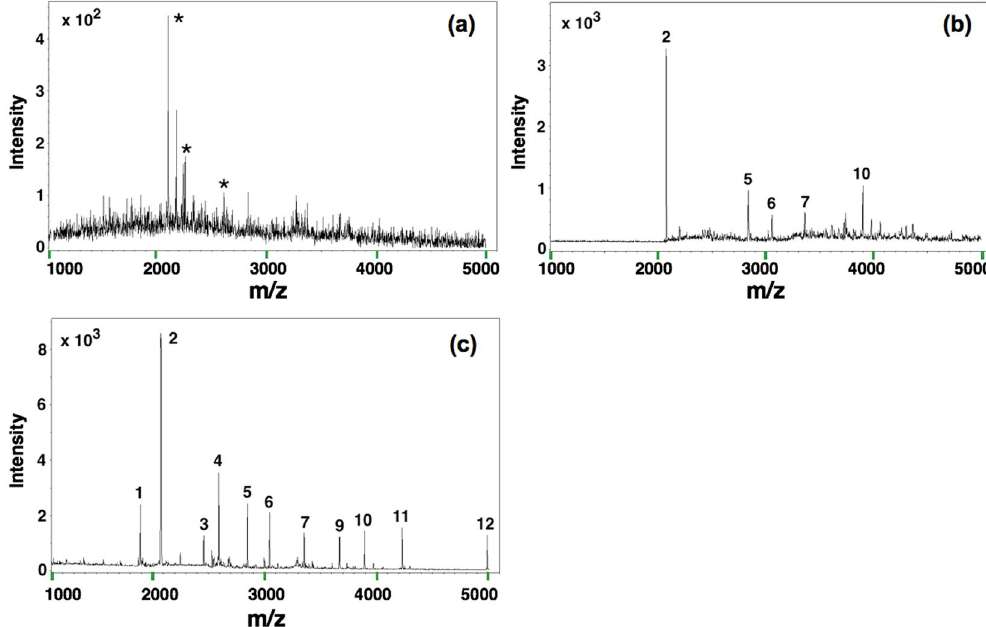
Figure 5. MALDI-TOF/TOF mass spectra of the tryptic digest of 0.1 ng/ μ L HRP: ( a ) without enrichment, ( b ) after enrichment by B-Fe 3 O 4 @mTiO 2 microspheres, and ( c ) after enrichment by B-Fe 3 O 4 @mTiO 2 microspheres and PMMA nanobeads. Note that asterisk marks label peaks of nonglycopeptide, and Arabic numbers label peaks of